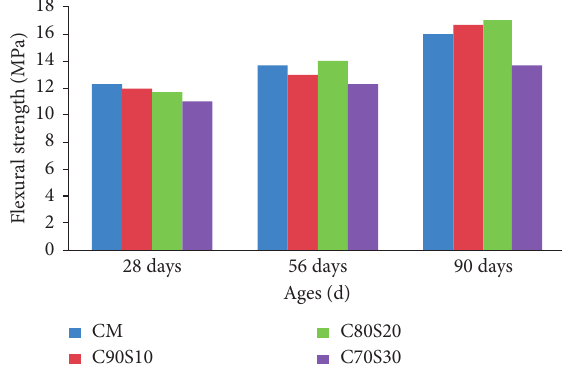
Figure 4: Flexural strength of concrete mixes at various curing